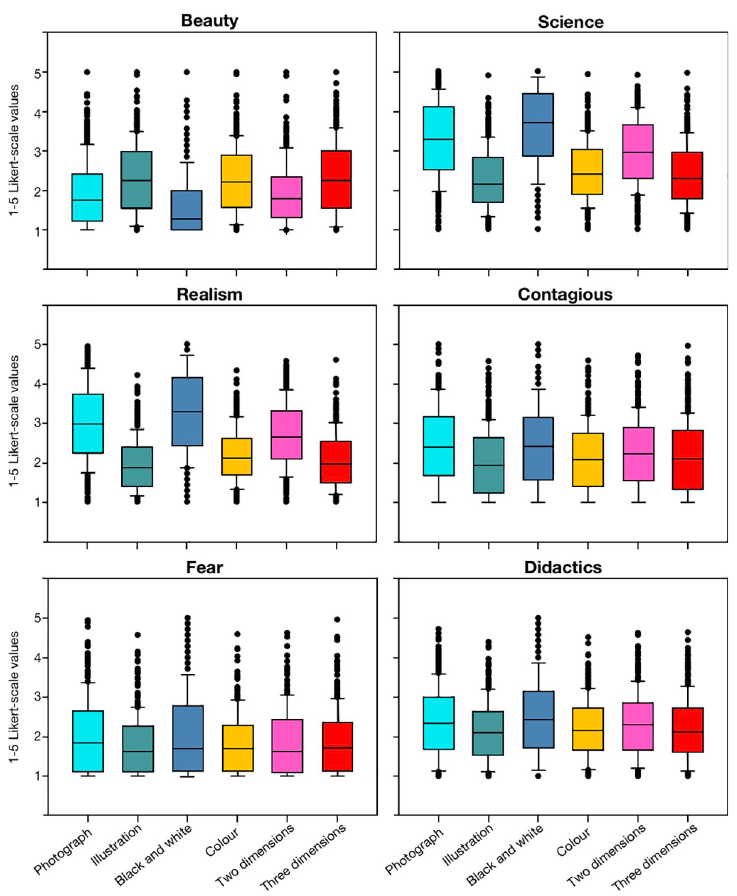
Fig 4. Box plot with the mean scores that each image obtained. Mean scores are distributed by category (beauty, scientific content, realism, infectivity, fear and didactic quality) and attribute (photograph, illustration, black and white, colour, two dimensions and three